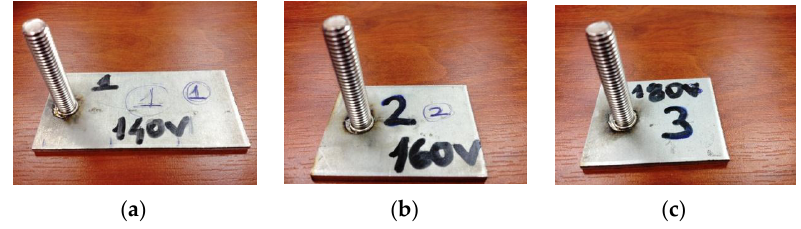
Figure 4. Arc stud welded joints: ( a ) Sample 1-140 V; ( b ) Sample 2-160 V; ( c ) Sample 3-180